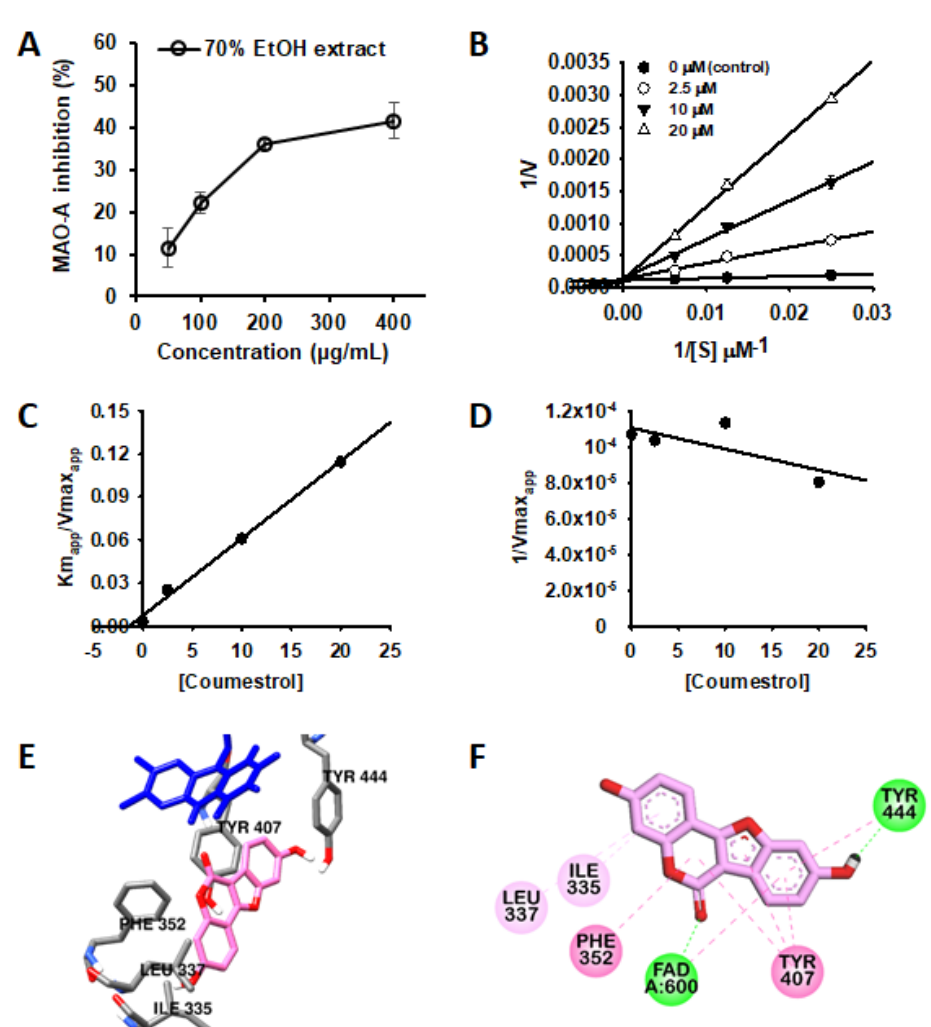
Figure 2. Dose-dependent inhibition of MAO-A by PL-L-70E ( A ). Lineweaver-Burk plots ( B ) and secondary plots ( C , D ) of coumestrol for h MAO-A inhibition. Data are presented as mean ± SD ( n = 3). Comparative binding orientation ( E ) and 2D interaction ( F ) of coumestrol (pink stick) at the catalytic site of h MAO-A. FAD and residues of the enzyme are represented as blue and gray sticks, respectively. Table 2. Inhibitory activity of the major constituents of PL-L-70E against h MAOs.